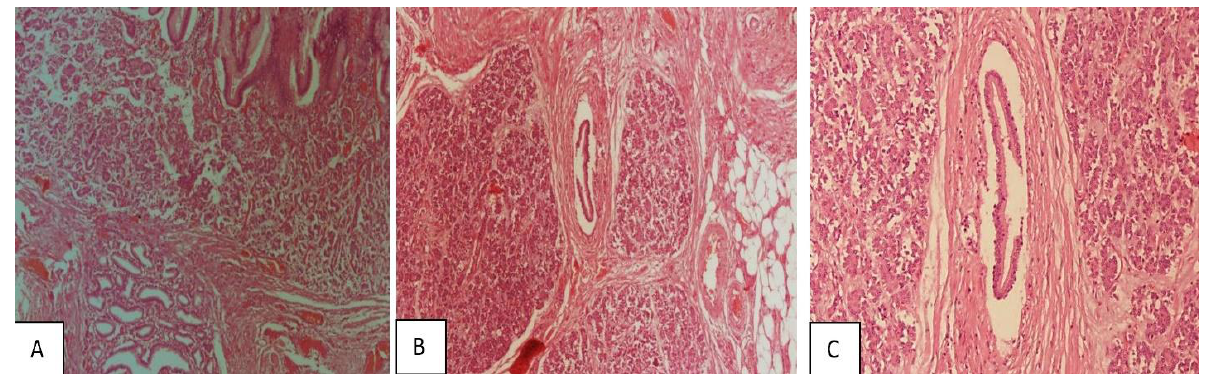
Figure 1. (A): Presence of pancreatic ducts and acini in mucosa and Submucosa of intestine. (B): Extension of the pancreatic tissue deep to sub serosa. (C): Pancreatic lobules and ducts in higher magnification.